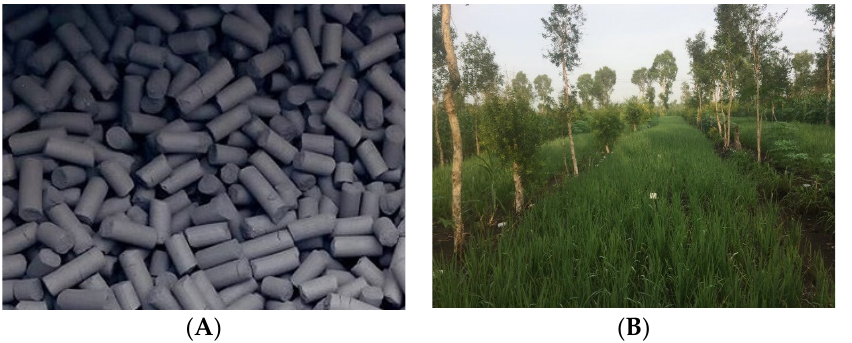
Figure 2. ( A ) Biochar briquettes sourced from kayu putih waste. ( B ) Hybrid rice between kayu putih stands. Table 1. The nutrient content and molar ratio of biochar briquettes. Chemistry Characteristics